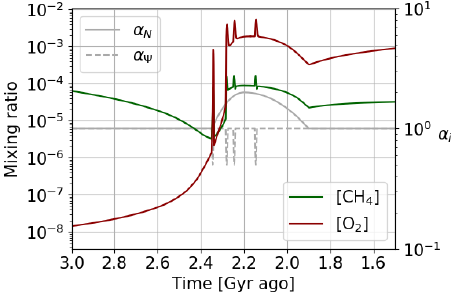
Figure 21. Oxygen and methane temporal evolution. Models with α N reaching a factor of 2. Models with α (cid:57) reaching a factor of 0.5 on shorter